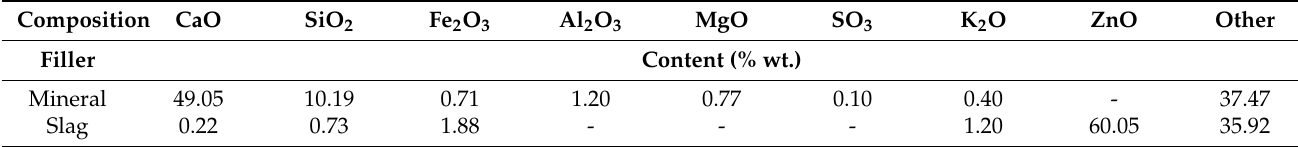
Table 4. Chemical composition (XRF).